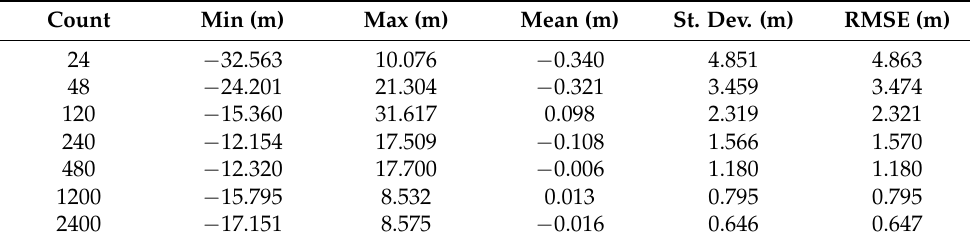
Table 4. Statistical terms of the residuals between each Universal Kriging model and initial dataset